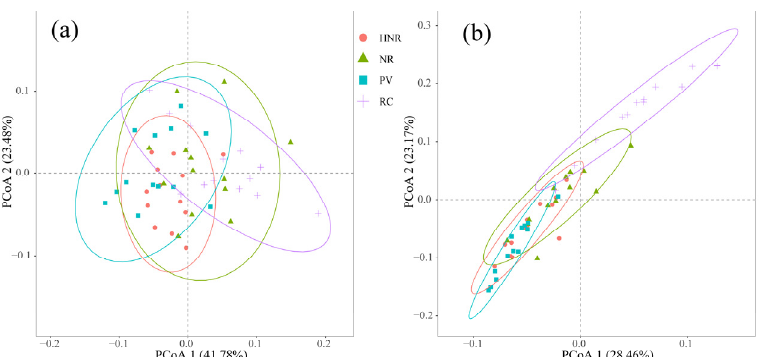
Figure 6. Study area based on phylum level ( a ) and genus level ( b ) PCoA analysis. Circles indicate 95% confidence intervals.